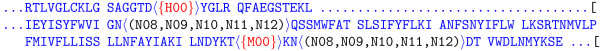
Structure of Enhanced Database. Consensus protein sequences NP_775259 (first line, residues 480 – 510 shown) and NP_076410 (second and third lines, residues 81 – 170 shown) are used as examples to demonstrate the structure of our sequence file, part of the enhanced database. A "[" character is always inserted after the last amino acid of each protein to serve as a separator. Annotated SAPs and PTMs associated with an amino acid are included in a pair of angular brackets following that amino acid. SAPs are further enclosed by a pair of curly brackets while PTMs are further enclosed by a pair of round brackets. Amino acid followed by two zeros indicates an annotated SAP. Every annotated PTM has a two-digit positive integer that is used to distinguish different modifications.